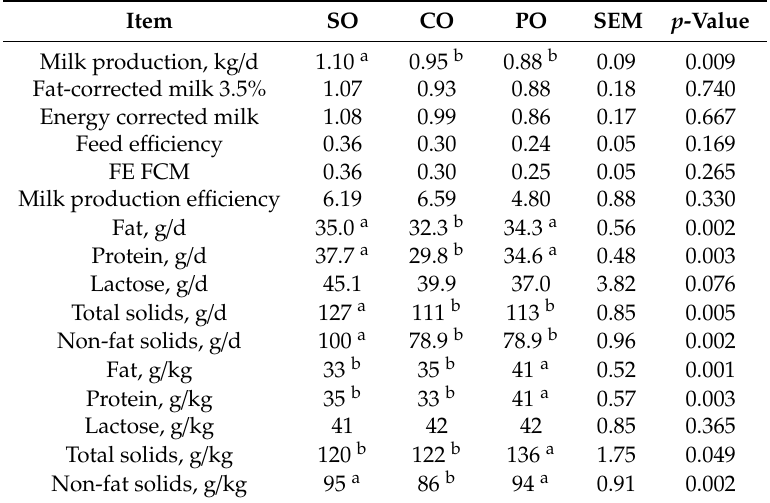
Table 5. Milk yield (kg / d) and milk composition from dairy goats supplemented with sa ffl ower oil (SO), canola oil (CO) and palm oil (PO) treatments 1 . Item